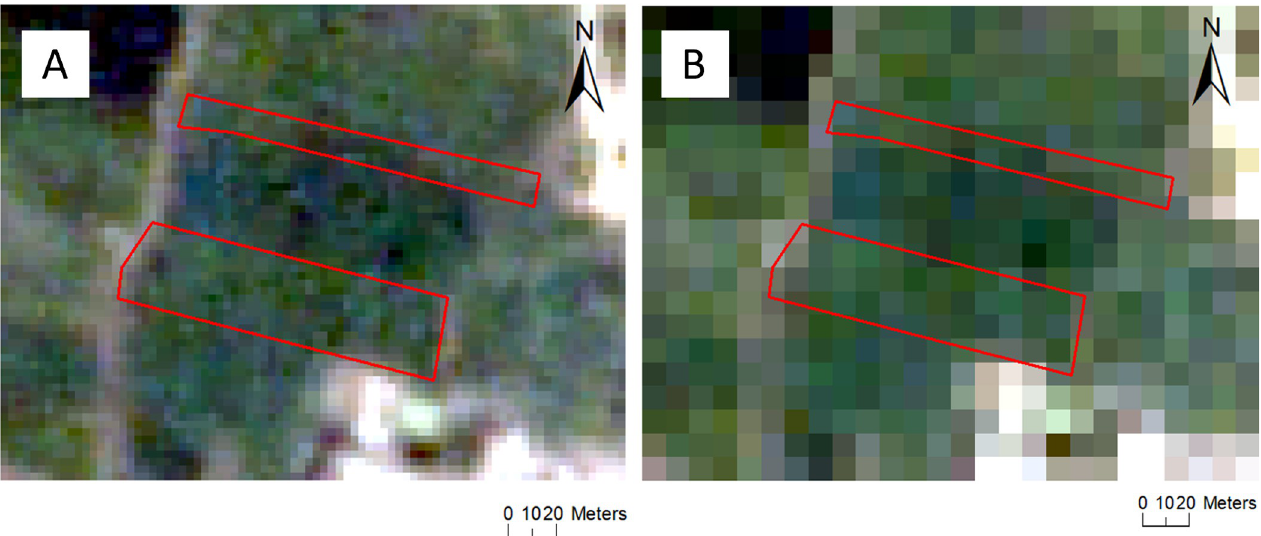
Fig 4. The boundaries of two field polygons overlaid on a (A) Planet image (3 m) and (B) Sentinel-2 image (10 m). Sentinel imagery was freely downloaded from the Copernicus Open Access Hub (https://scihub.copernicus.eu/).